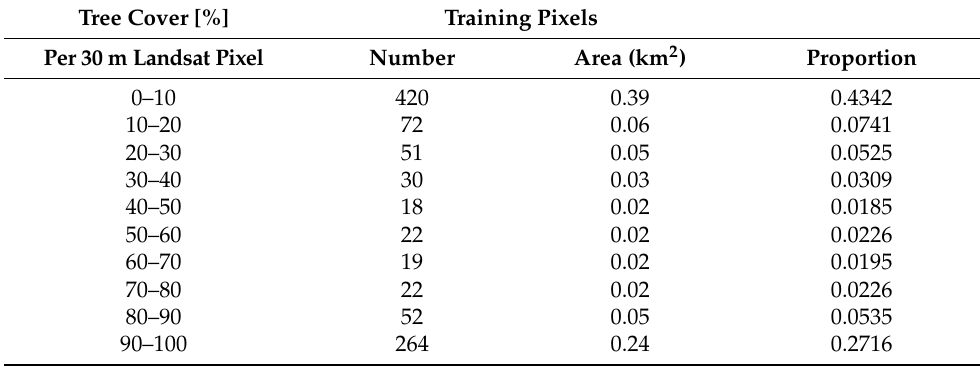
Table 1. Distribution of training pixels over the 10% tree cover classes.